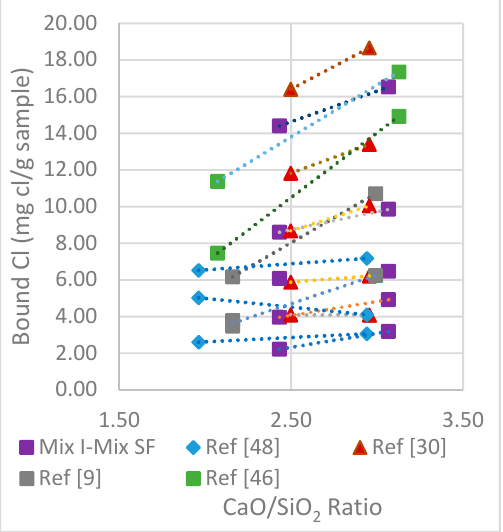
Figure 7. Relationship between CaO/SiO 2 ratio (main varying-parameter) and bound chloride for different chloride concentrations.